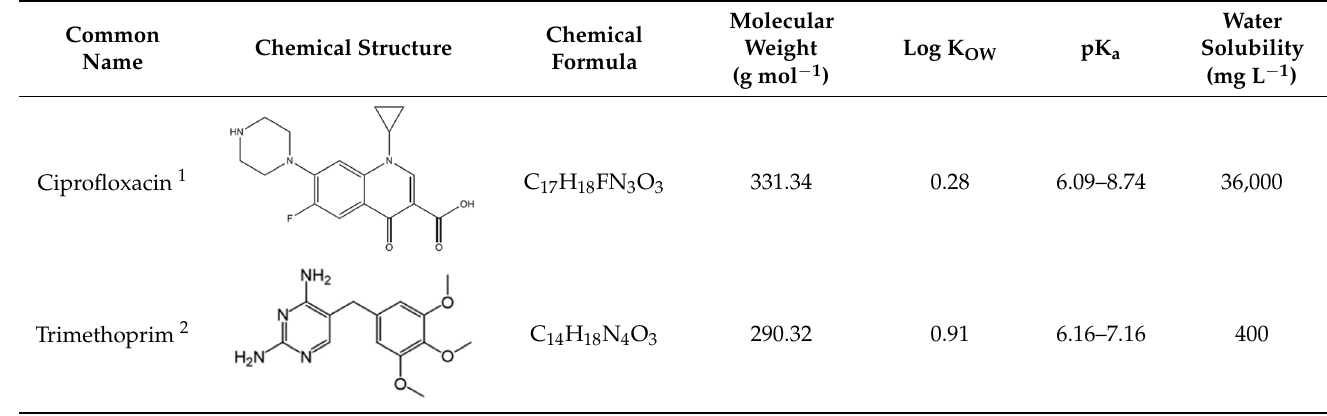
Table 1. Main characteristics of the antibiotics studied. K OW: coefficient of partition octanol/water.